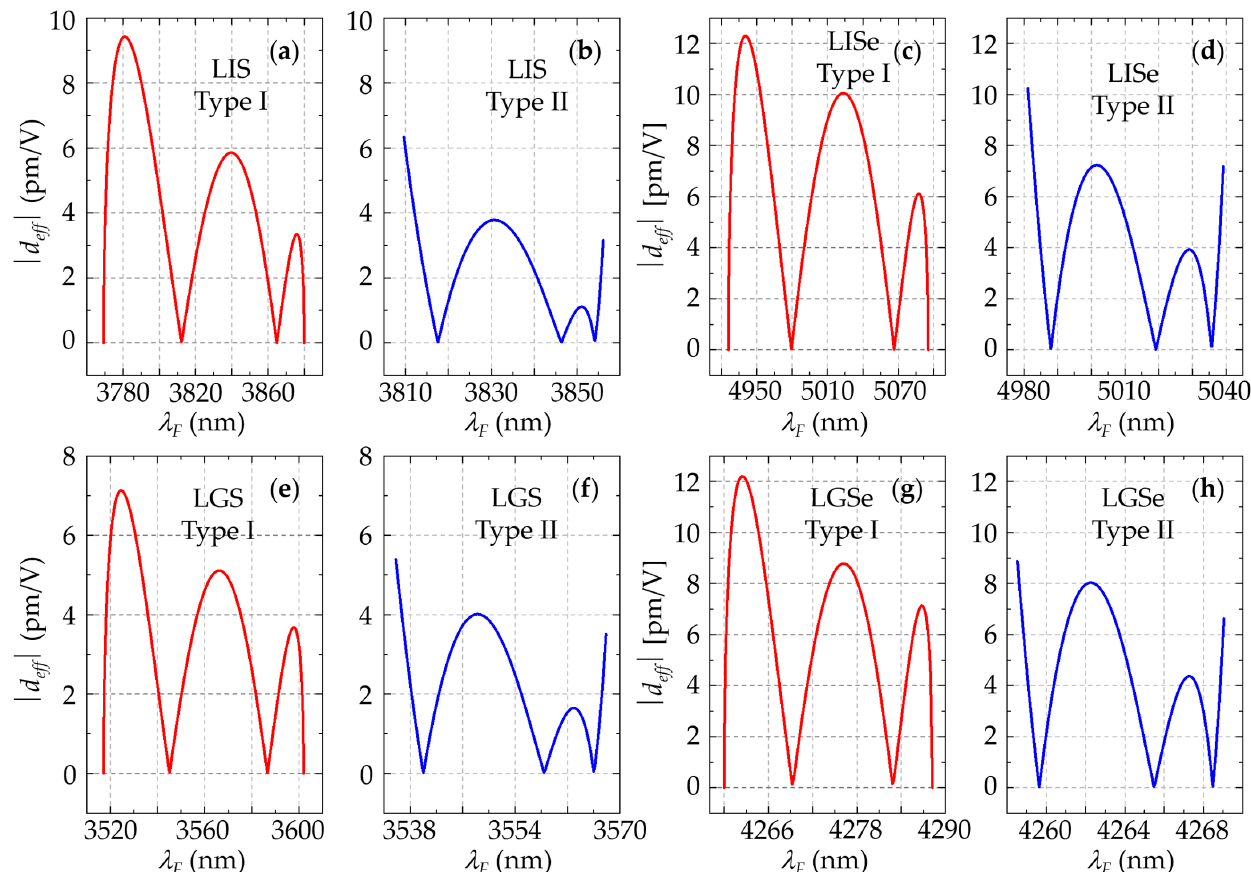
Figure 9. The effective NLO coefficient ( d eff ) plotted as functions of λ F satisfying the broadband SHG conditions. ( a ) Type I and ( b ) Type II in LIS; ( c ) Type I and ( d ) Type II in LISe; ( e ) Type I and ( f ) Type II in LGS; and ( g ) Type I and ( h ) Type II in LGSe. Table 8. Broadband SHG conditions for the maximum d eff : the resonant F-wavelength ( λ F ), the direction of the F-wave vector (i.e., θ and ϕ ), the effective NLO coefficient ( d eff ), the walk-off angle ( w ), and the acceptable bandwidth of the F-wave ( ∆ λ F ). Crystals BPM